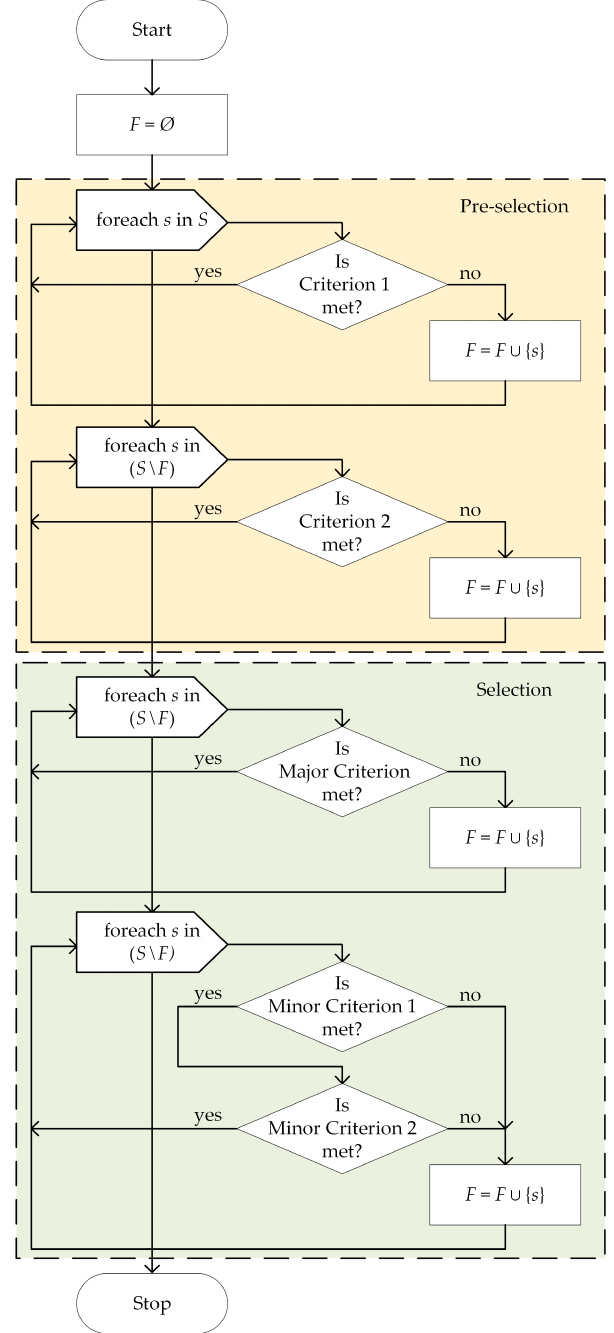
Figure 2. The flow diagram of sensor pre-selection and actual selection. S , set of sensors, F , set of sensors that have not passed all the selection steps so far, ( S \ F ) , set of sensors that have passed all the selection steps so